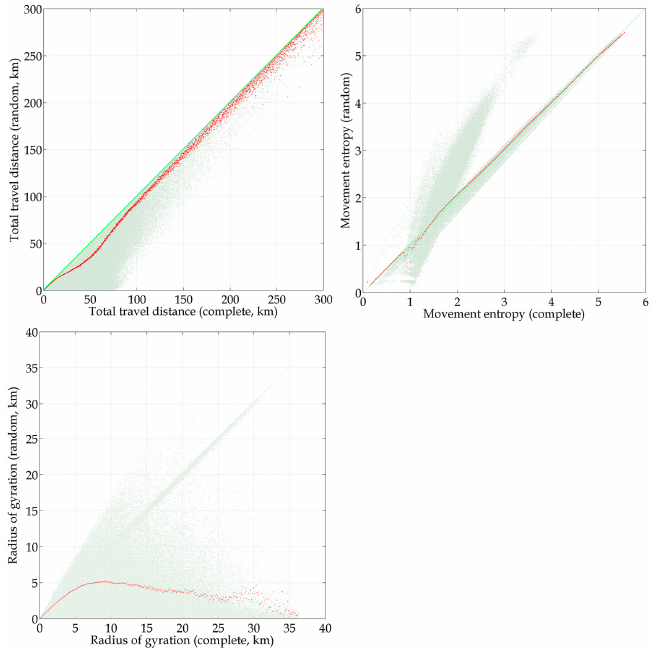
Figure 9. Human mobility indicators in 23 random segments (segment #0, #1, #2, #3, #4, #6, #7, #8, #9, #10, #11, #12, #13, #14, #15, #16, #17, #18, #19, #20, #21, #22, and #23). The light gray dots are the three random and complete mobility indicators for each subscriber. For the total travel distance and radius of gyration, the horizontal axis is 0.1 km bandwidth. For movement entropy, the horizontal axis is 0.01 bandwidth. The red dots are the average of the gray dots in their corresponding bandwidth.